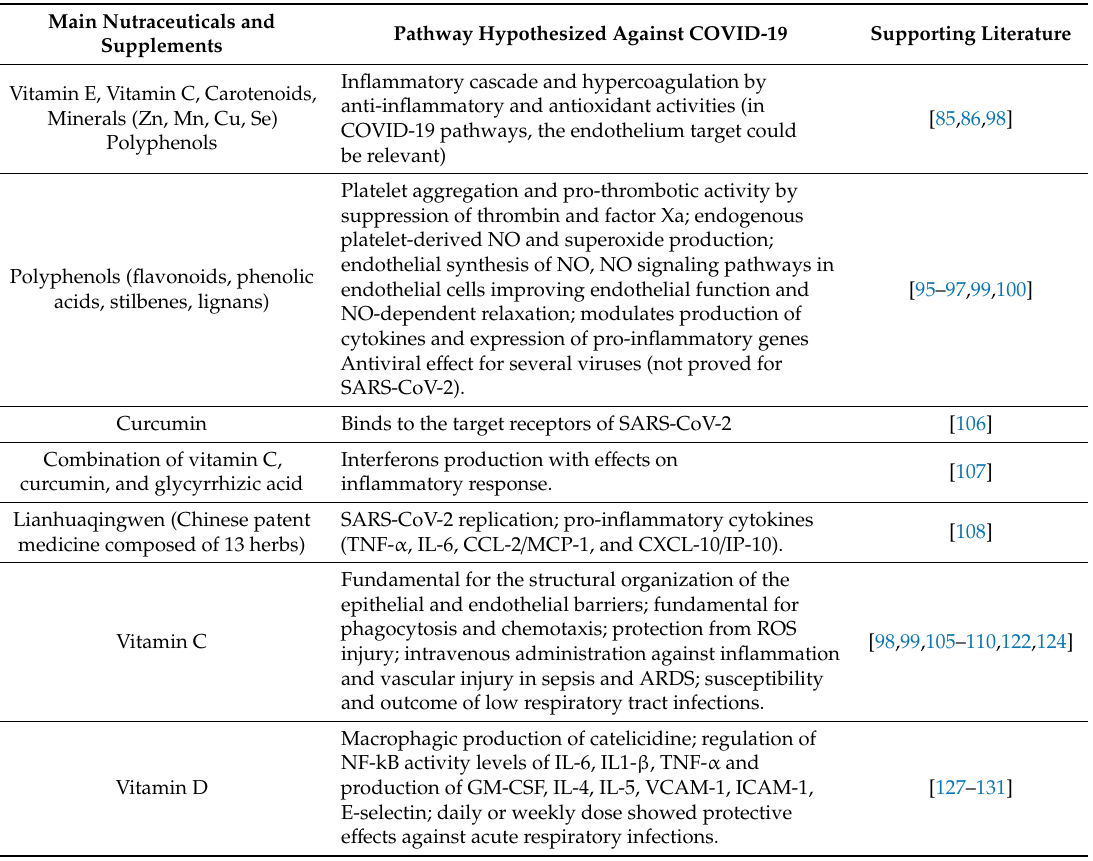
Table 2. Main nutraceuticals and supplements with potential role in countering COVID-19 pathways. Main Nutraceuticals and